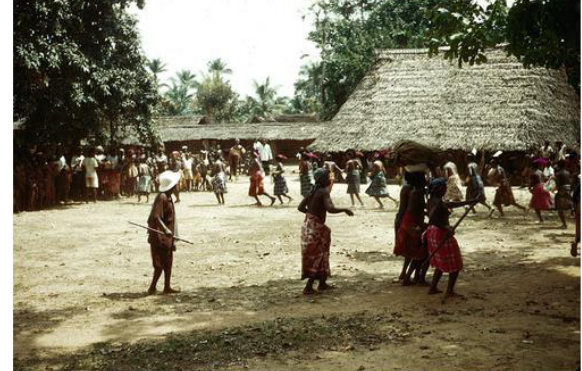
Figure 12 i. An Activity Taking Place in an Igbo Community Village